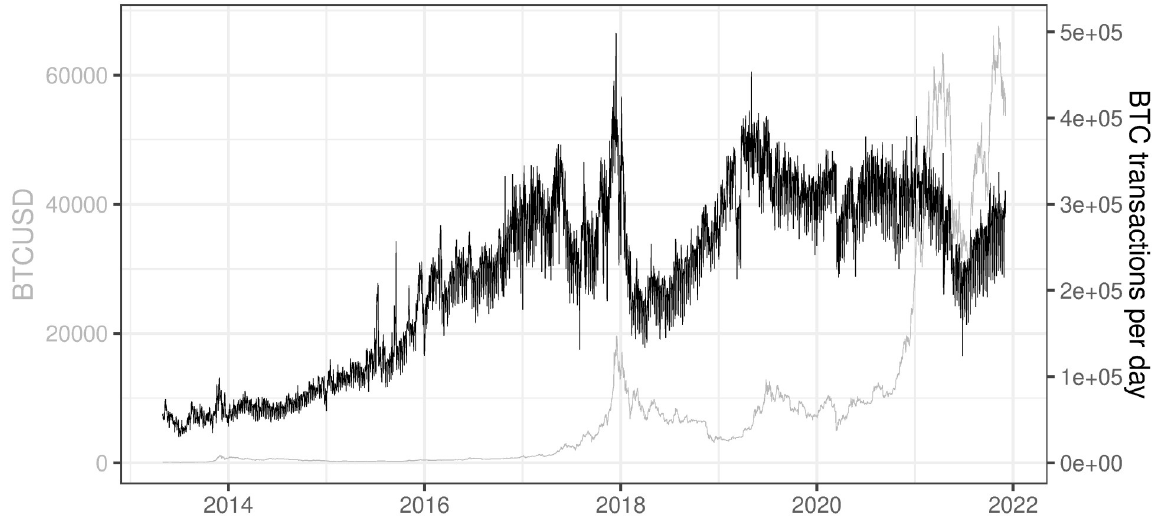
Fig 13. BTC transactions per day. Note: Data covers the period between 2013/05/01 to 2021/12/03. Source: https://charts.coinmetrics.io/ network-data/.